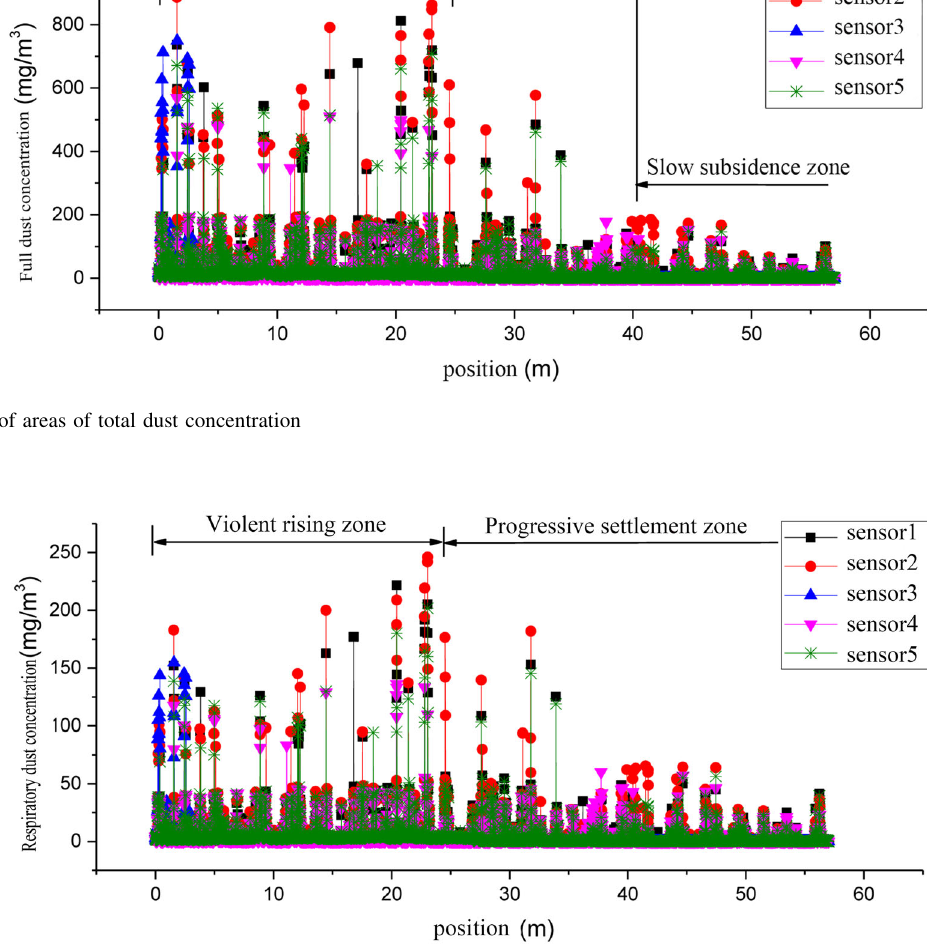
b Fig. 3 Total dust concentration changing with time, measured using the sensors